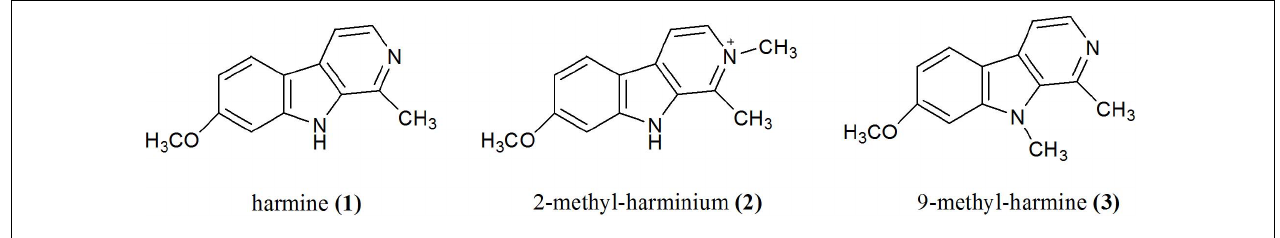
FIGURE 1 | Chemical structures of β Cs studied in this